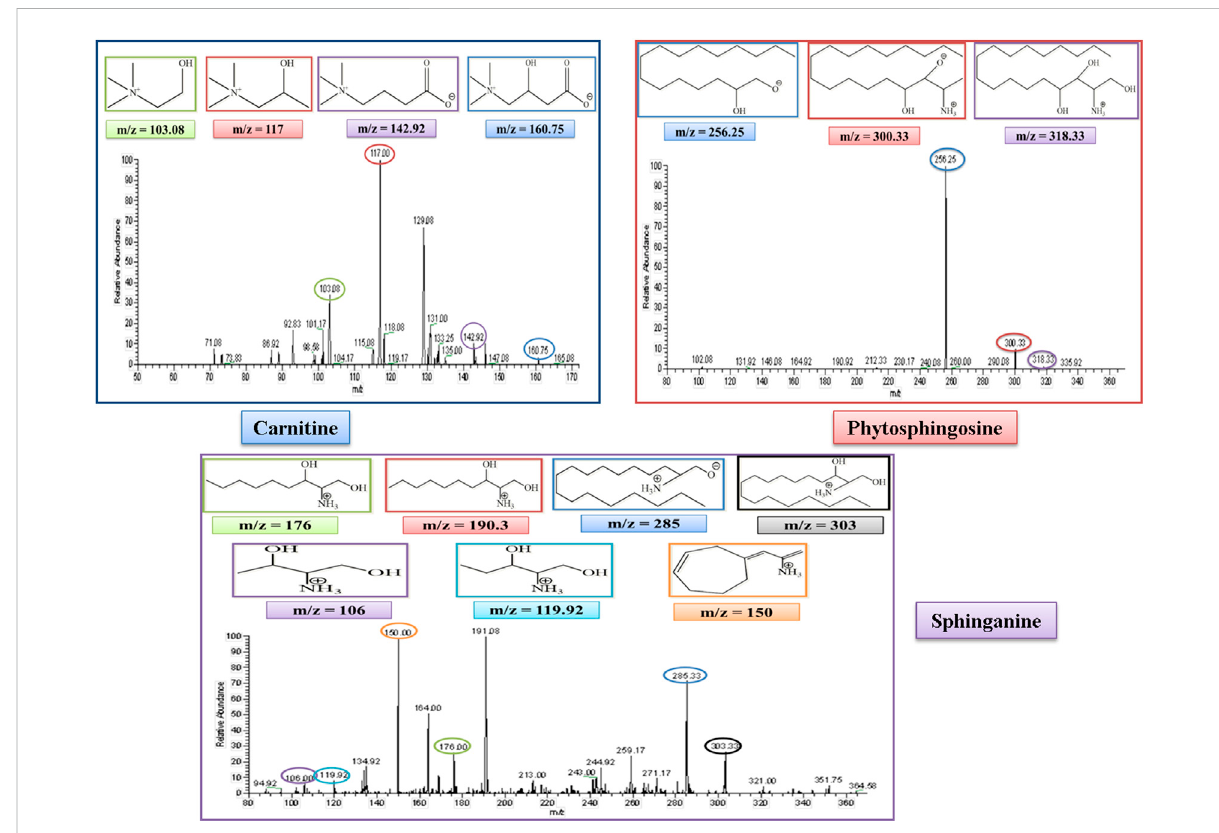
FIGURE 6 MS/MSspectrumofL-carnitine,phytosphingosine, andsphinganineinnegativeandpositiveionmode,respectively.Eachm/zpeakiscircledby a color similar to the color of the border of its